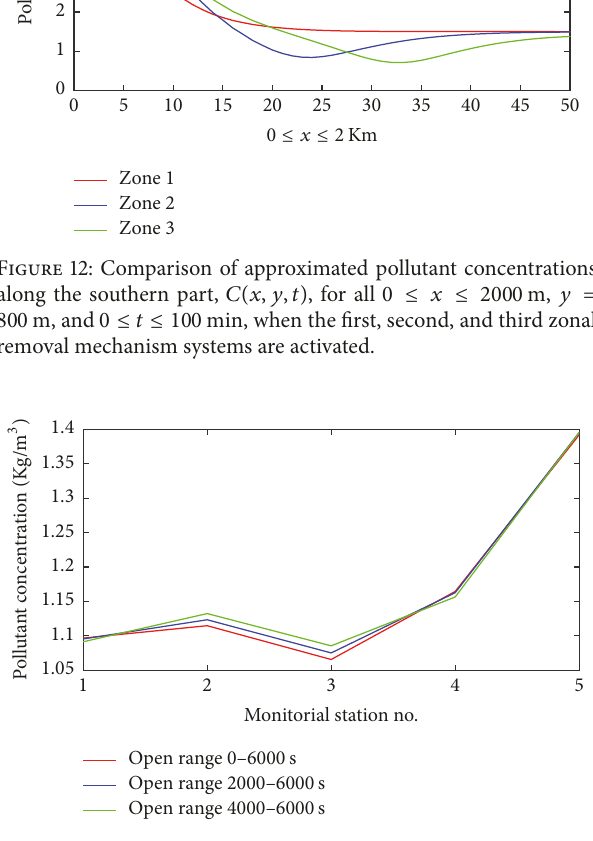
Figure 15: The overall approximated pollutant concentrations when the eastern exit gate is opened on the period